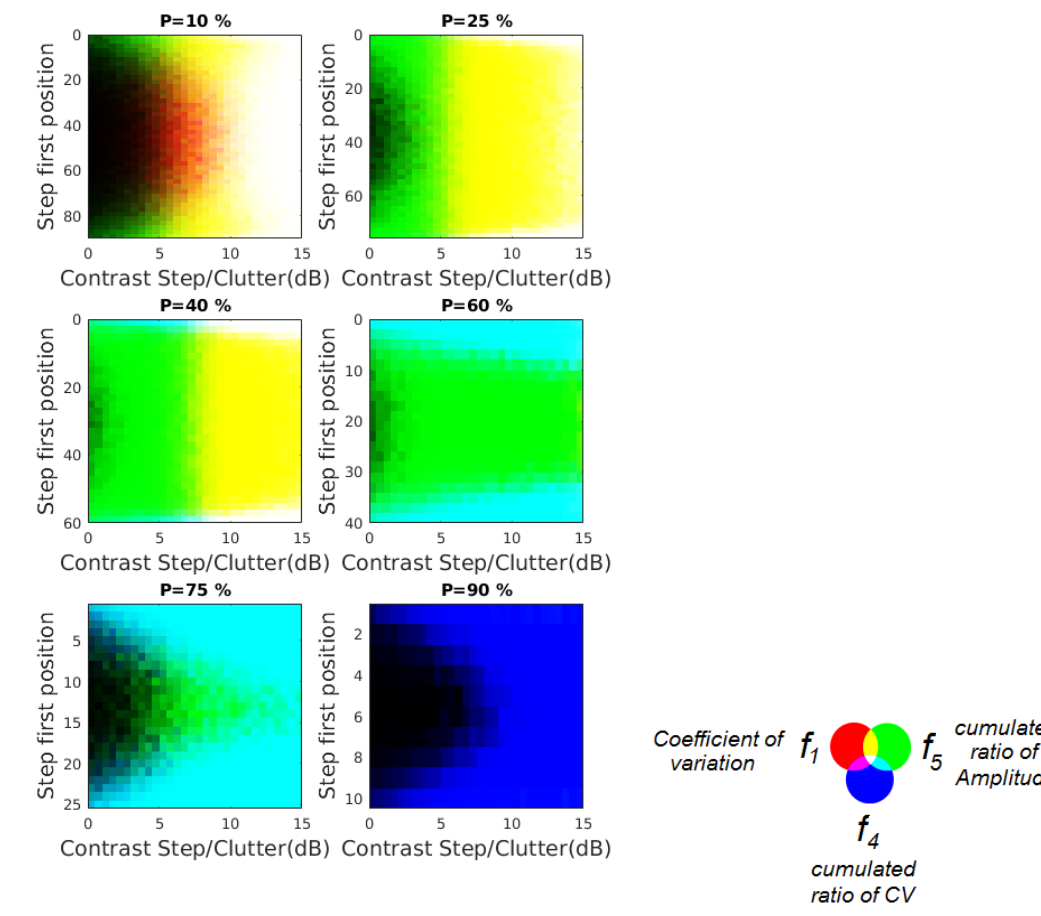
Figure 6. Probability of detection of f 1 , f 4 , and f 5 for False Alarm 0.1%, for steps with six different lengths of time, for varying step position and